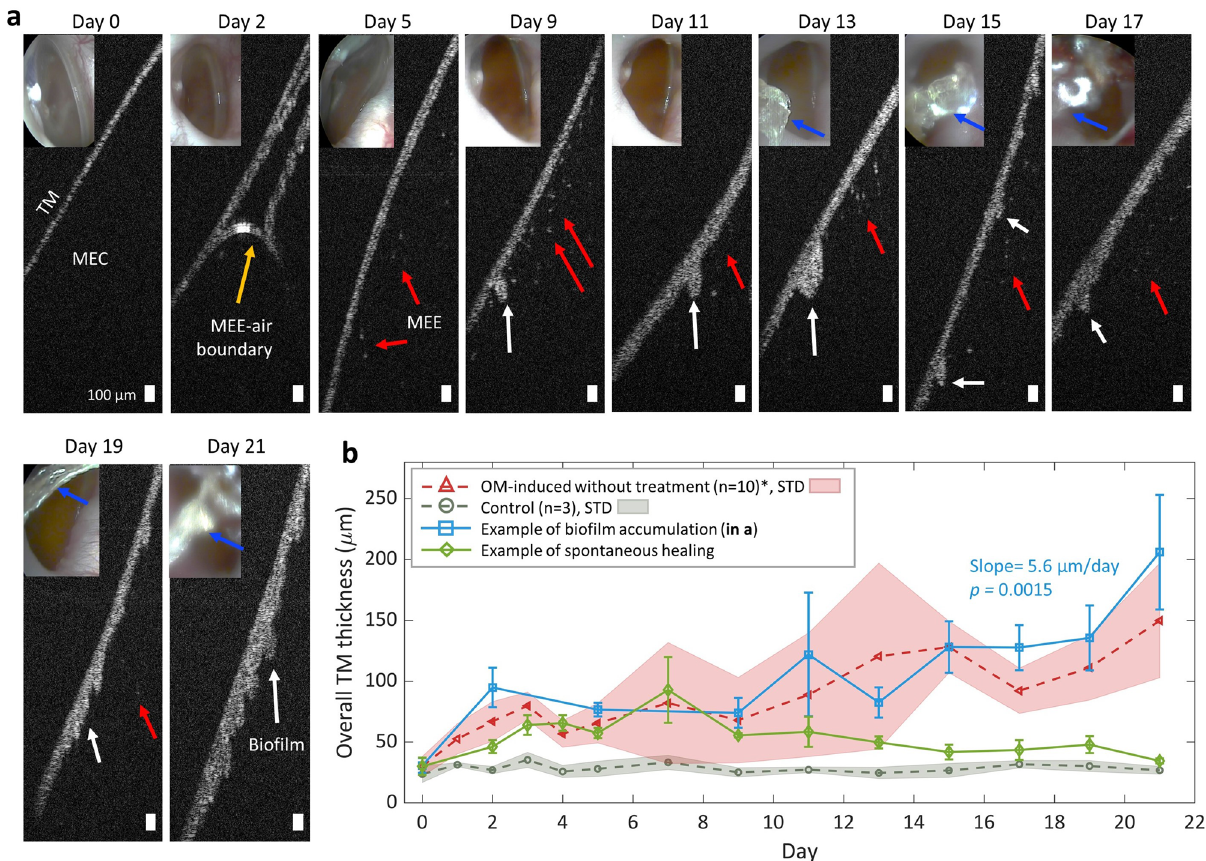
Figure 3. Formation and growth of a TM-adherent biofilm in vivo. ( a ) OCT and otoscopy (inset) images showing the formation of the biofilm in an AOM-induced chinchilla. Starting day 9, a cluster of biomass adhered to the TM was observed, which continued to accumulate until day 21 (white arrows). Blue arrows indicate earwax that limited visual assessment of the TM. Scale bars represent 100 µm. ( b ) The averaged TM thickness and standard deviation were plotted for the control (n = 3) and OM-induced group (n = 10), where n indicates the number of animals. Note that animals longitudinally tracked for longer than day 3 post-inoculation are included in the plot. The thickness measured from the specific animal in ( a ) is shown in blue. The positive slope from the linear polynomial fitting with a p- value of 0.0015 indicates a significant increasing trend in the thickness. STD standard